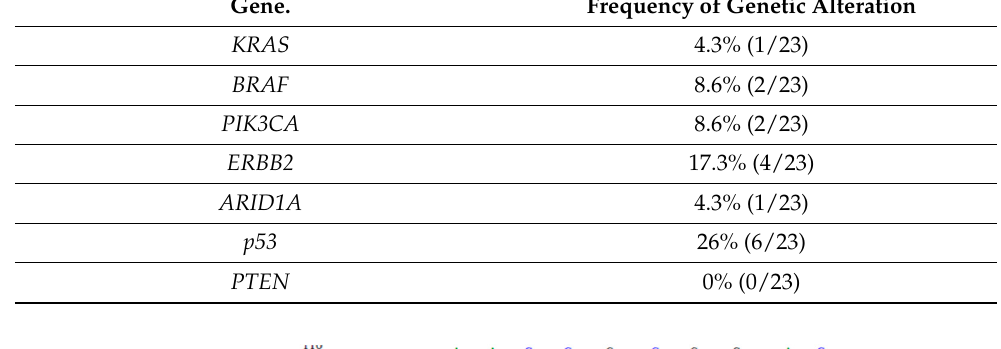
Table 3. Mutation frequency in the 23 SMBTs.